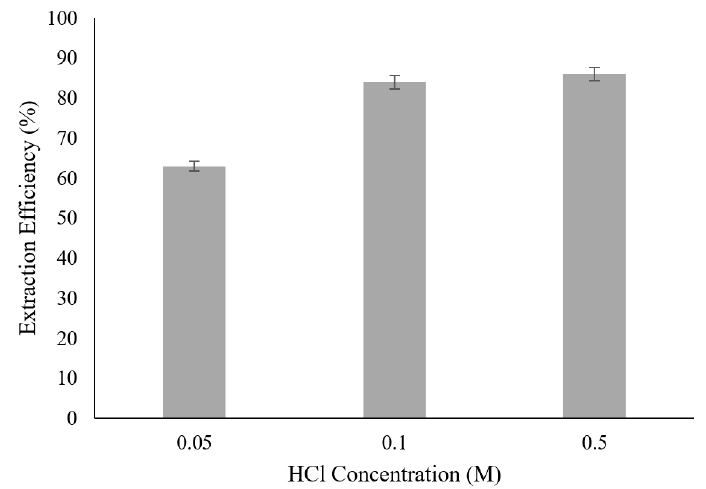
Figure 4. Effect of Volume Ratio Membrane to Internal Phase (Experimental condition: [Ammonia] = 0.1 M; [TOA] = 6 wt%; [Span 80] = 6 wt%; Organic to Internal Ratio = 3:1; Stripping Agent = Ammonia; Diluent = Kerosene).